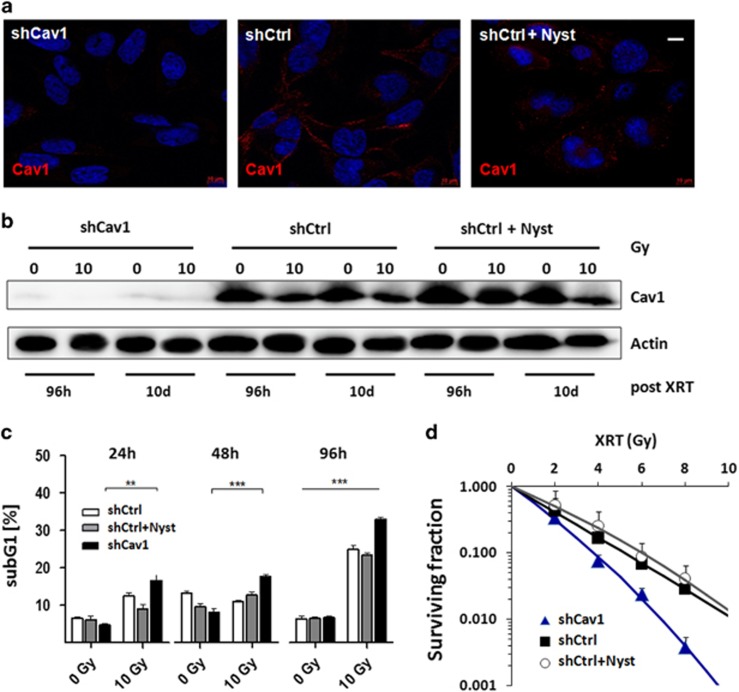
Reduction of Cav1 levels increased radiation-induced endothelial cell death and decreased the survival of clonogenic ECs. (a) Cav1 expression and localization was analyzed in cultured shCav1-transfected and control-transfected (shCtrl) AS-M5 ECs by immunofluorescence (red). Nuclei were stained in blue. In addition, control-transfected AS-M5 cells were treated with nystatin (10 μg/ml) in order to inhibit caveolae formation (shCtrl+Nyst). (b) Cav1 expression was further determined using western blot analysis. (c) The degree of apoptosis was quantified by measuring the SubG1 fraction after radiation by flow cytometry analysis. SubG1 levels were related to the 0 Gy (control) value (set as 1). (d) AS-M5 cells were plated for colony formation assay, irradiated with indicated doses and subsequently further incubated for additional 10 days. Data show the surviving fractions from three independent experiments (means±s.d.).